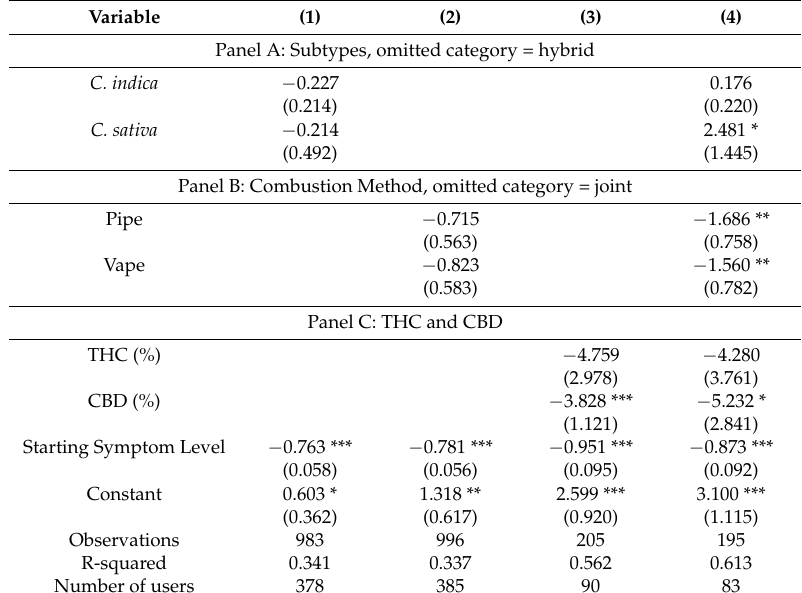
Table 2. Effects of Product Characteristics on Symptom Relief—Regression Results.